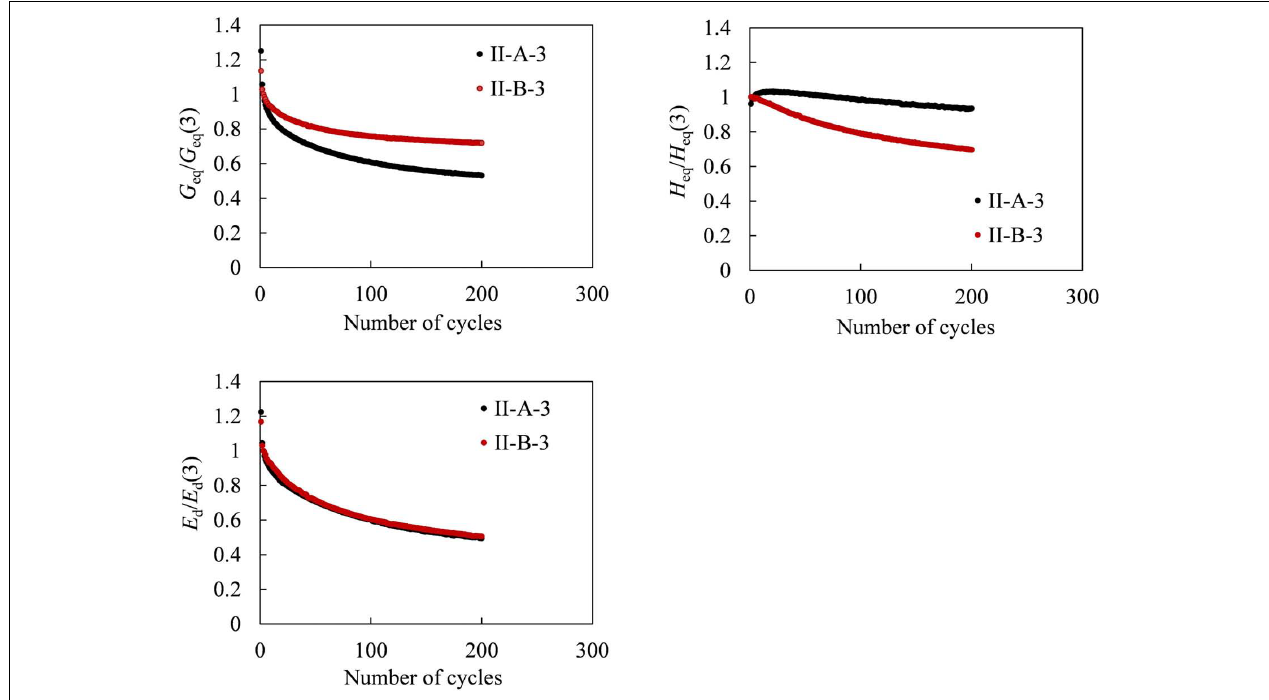
FIGURE 10 | Relationship of change of properties and number of cycles in scale-II-A and -II-B.